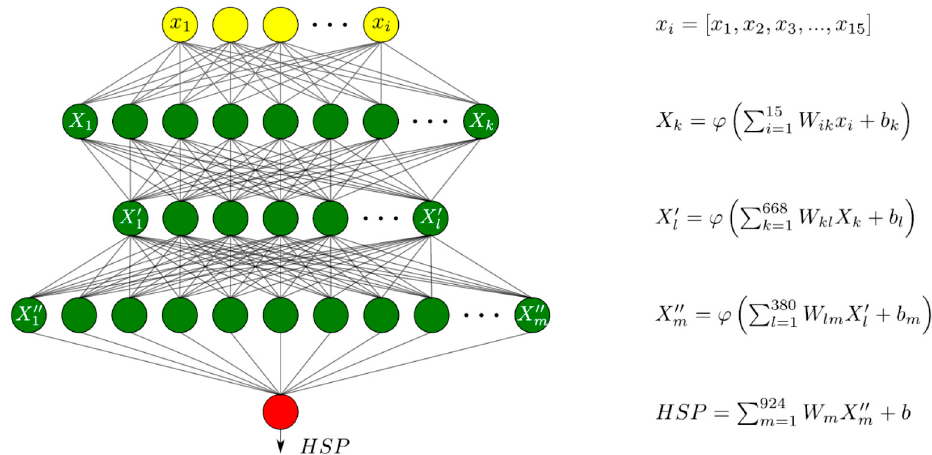
Figure 3. Deep feedforward artificial neural network architecture. Input layer, output layer, and hidden layer nodes are marked in yellow, red, and green colors, respectively. The corresponding outputs of the layer nodes are shown at the right side of the image. The input data of the nodes was multiplied with the weights (W), and their summation obtained an addition of bias (b ). The weights and bias transformed the input data linearly. The non-linear transformation was performed by the rectified linear unit (ReLU) activation function ( ϕ ) defined as f ( x ) = max ( 0,x ) .